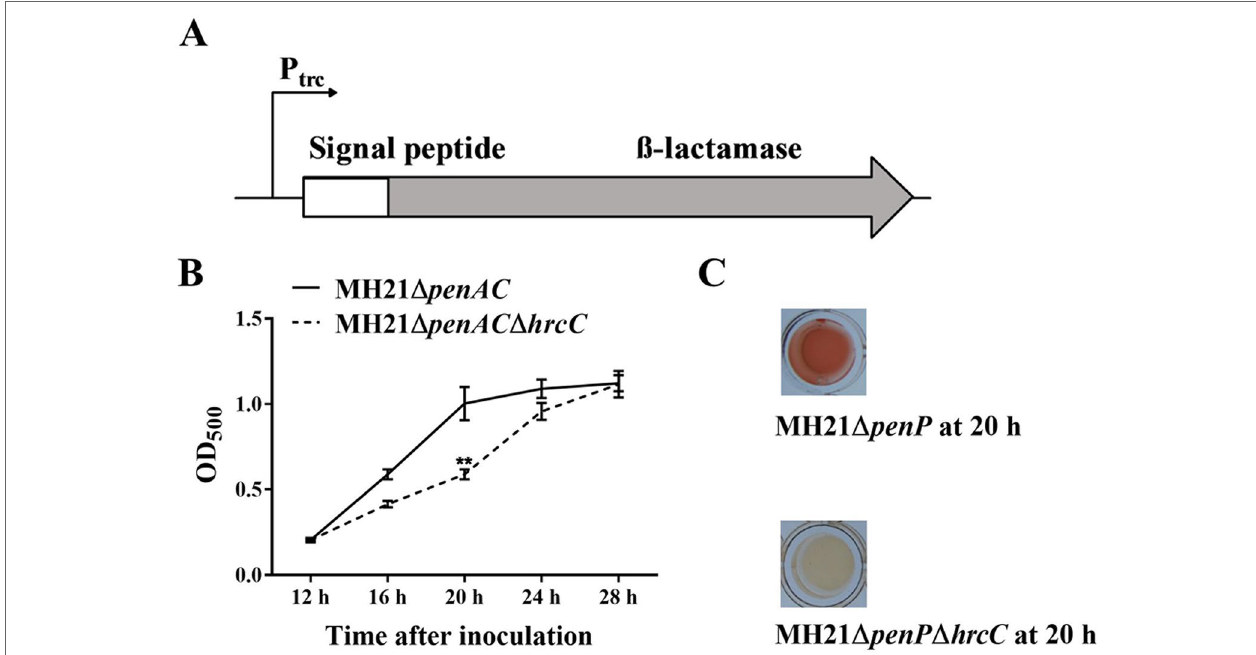
FIGURE 1 | Reporter structure and suitable growth state of reporter strain Acidovorax citrulli MH21Δ penAC (pZAC-3502sig- penAC ) . (A) Reporter structure on plasmid pZAC-3502sig- penAC . The P trc promoter driven β -lactamase gene was fused with a signal peptide sequence of the T3SS effector gene ( Aave_3502 , a hopAO1 homologous gene). (B) Extracellular β -lactamase activity of MH21 ΔpenAC and its T3SS mutant MH21Δ penAC Δ hrcC cultured in hrp -inducing medium. β -lactamase activity was measured spectrophotometrically by determining the OD 500 . Experiments were performed twice with three biological replicates. Statistically significant differences (Student’s t-test) were observed at 20 h post inoculation. P-value < 0.05 (**). (C) The reaction mixture containing the reporter plasmid in the T3SS mutant MH21Δ penAC Δ hrcC remained yellow, but changed into red in mixture containing the T3SS wild-type strain MH21Δ penAC